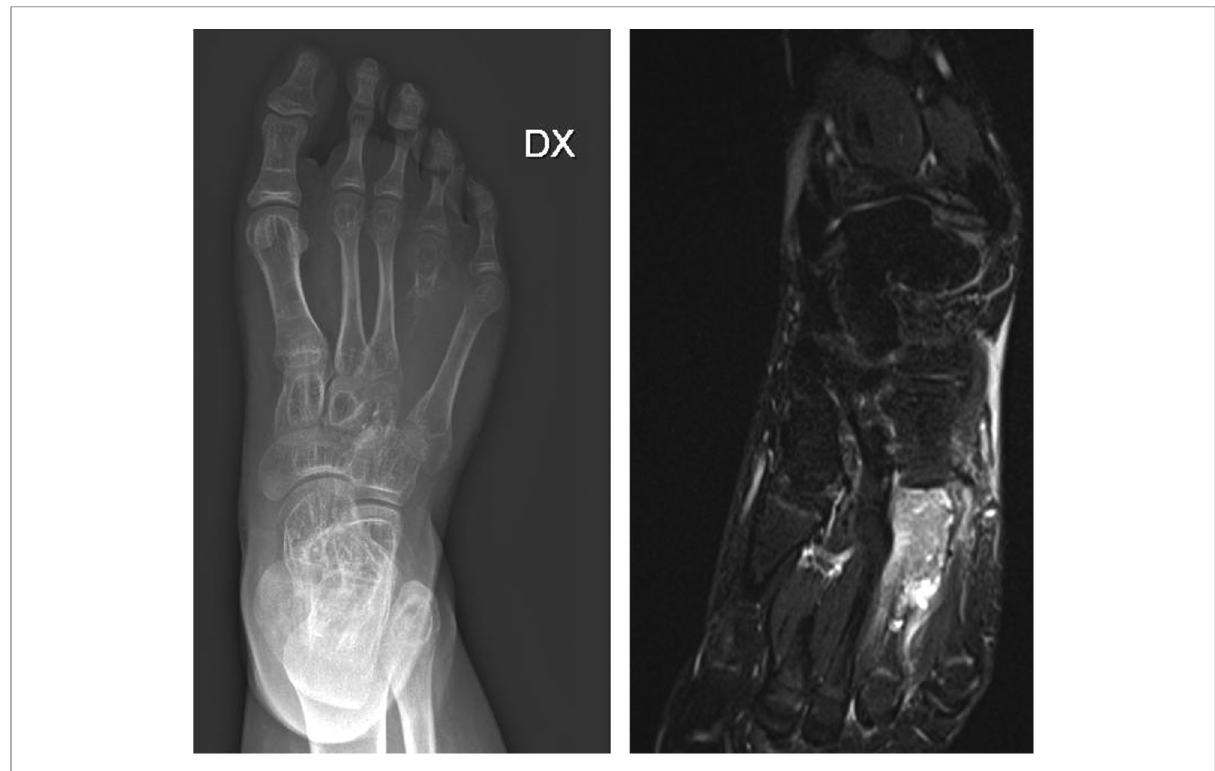
FIGURE 1 Pre-operativex-ray A/P ( A ) and MRI ( B ) view showing an expansile, lytic, encapsulated and iso-intense destructive lesion of the fourth metatarsus with soft tissue